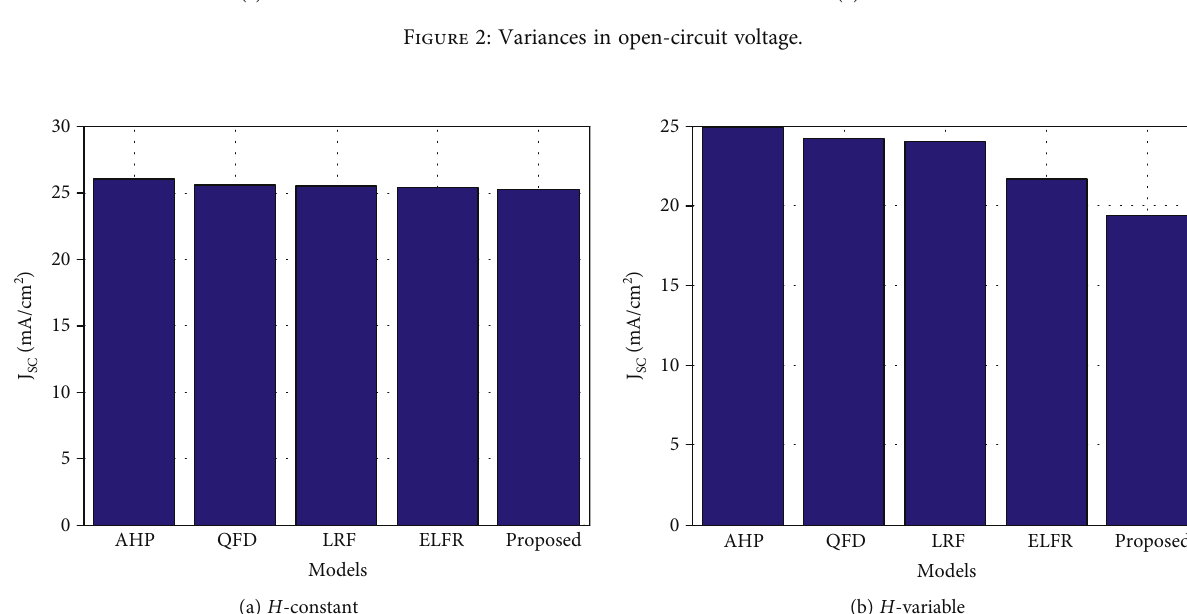
Figure 2: Variances in open-circuit voltage.